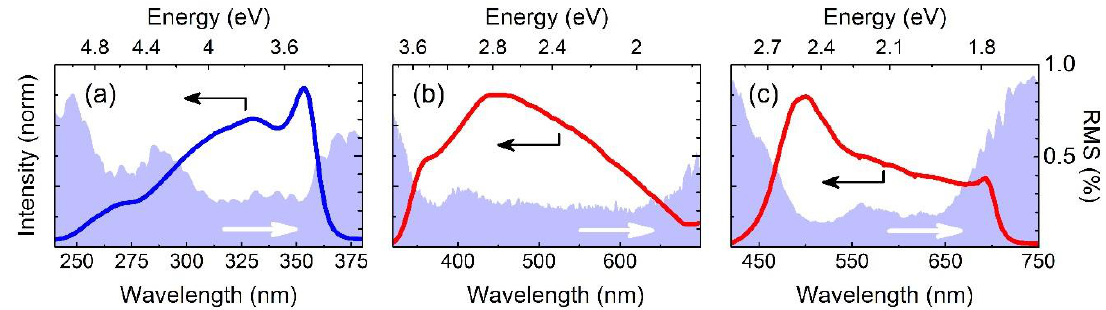
Figure 5. Solid lines: spectra of the WLC generated in CaF 2 with the SH pump ( a ), in CaF 2 with the FW pump ( b ) and in sapphire with the FW pump ( c ). Shaded areas: shot-to-shot wavelength dependent rms of the WLC fluctuations.